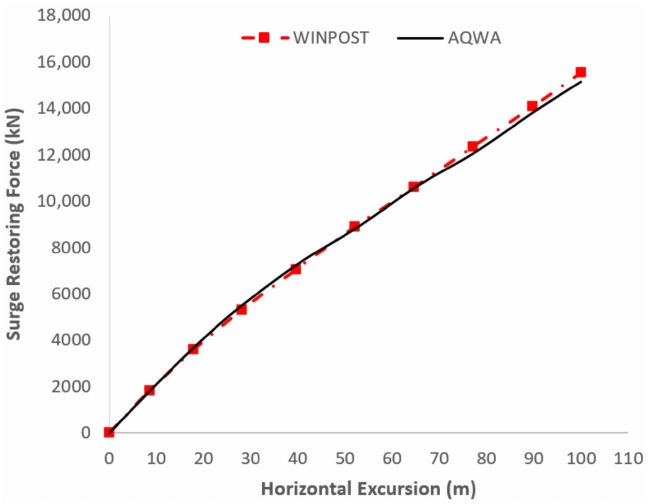
Figure 6. Comparison of restoring behavior of WINSPOST and AQWA models.